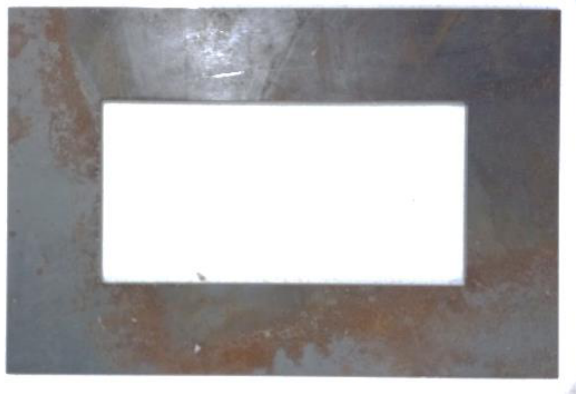
Fig. 2. The plate